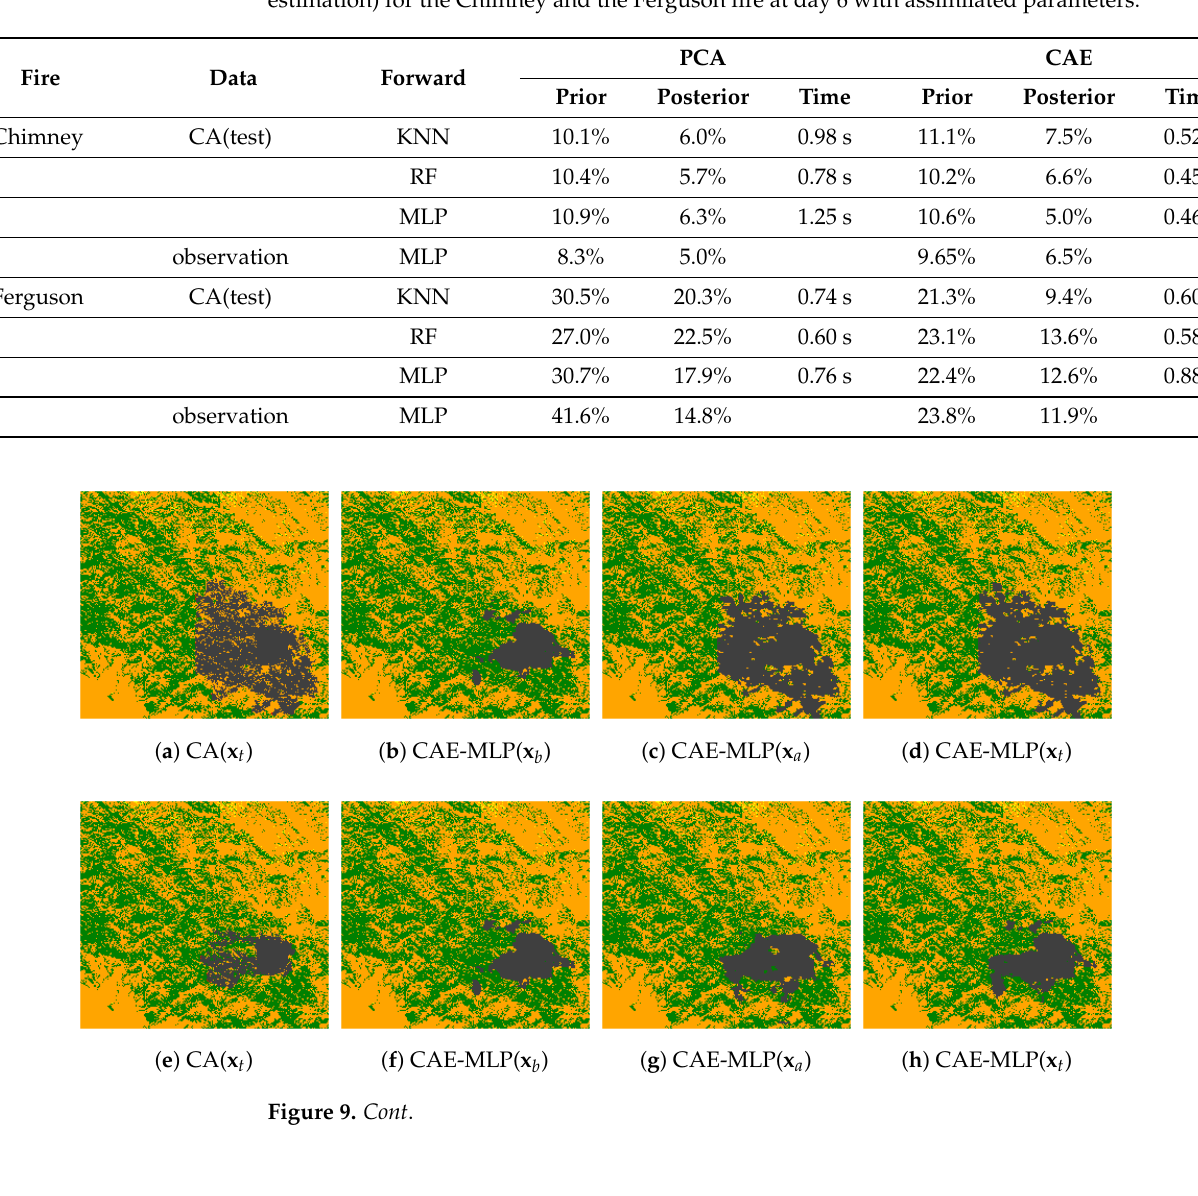
Table 6. Relative prediction error and the averaged computational time (only the LA for parameter estimation) for the Chimney and the Ferguson fire at day 6 with assimilated parameters.